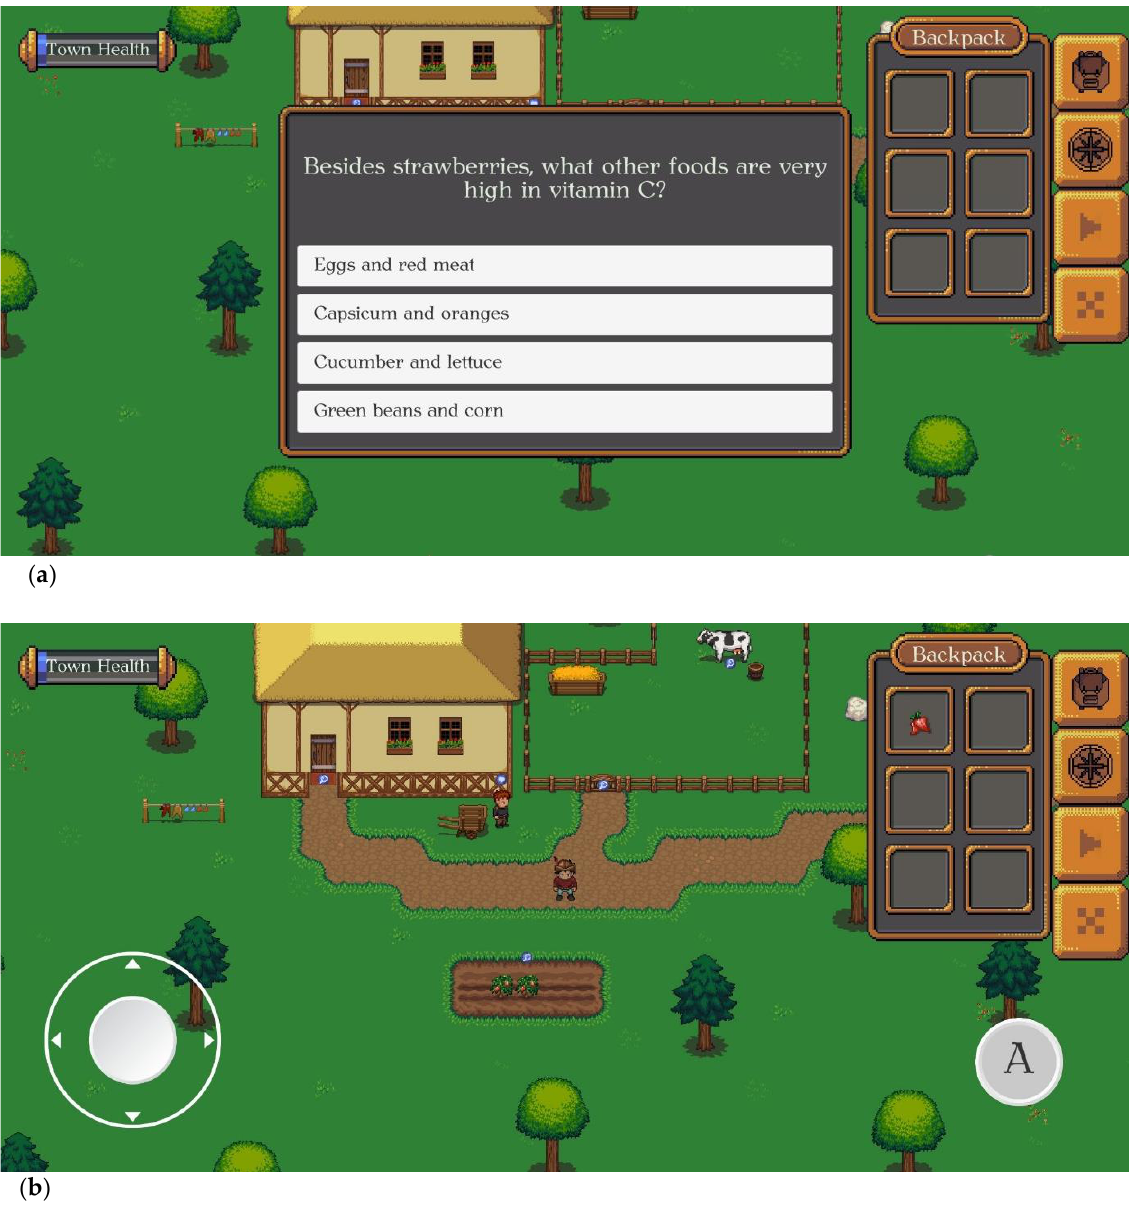
Figure 4. ( a ) A quiz question pops up after planting the seeds. The crop will grow to full size by correctly answering three questions. ( b ) After three correct responses, the crop can be harvested and delivered to the NPC villager in return for points towards the ‘town health’ (see top left -hand corner).